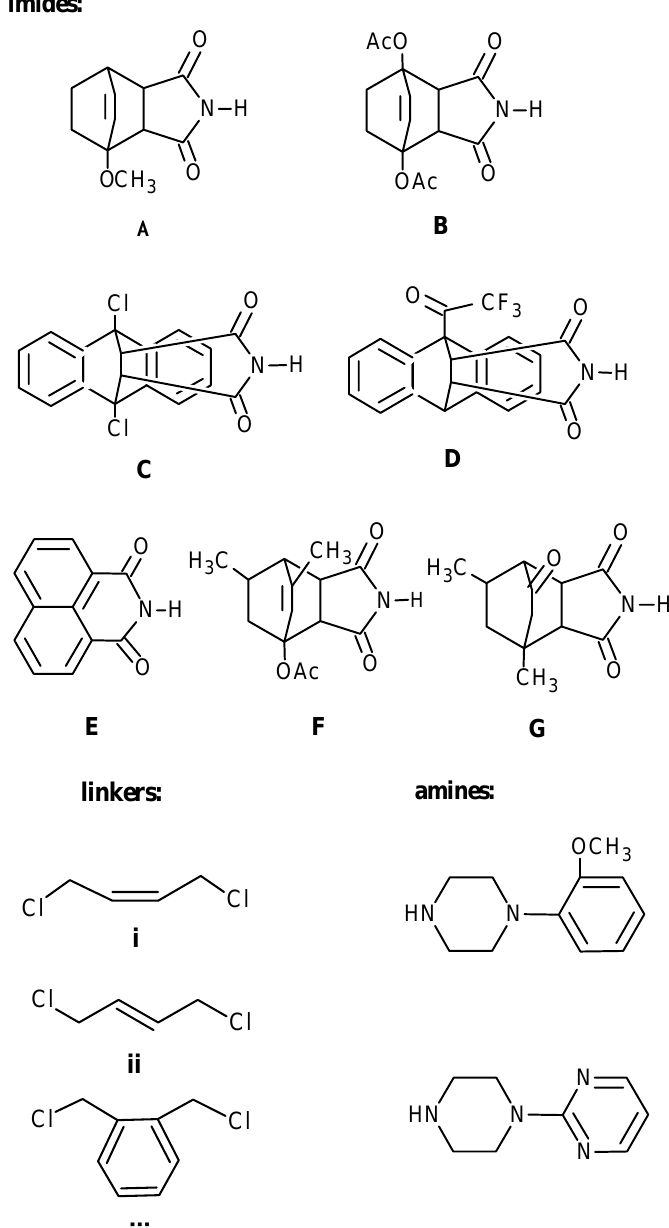
Figure 1 . The components used in the